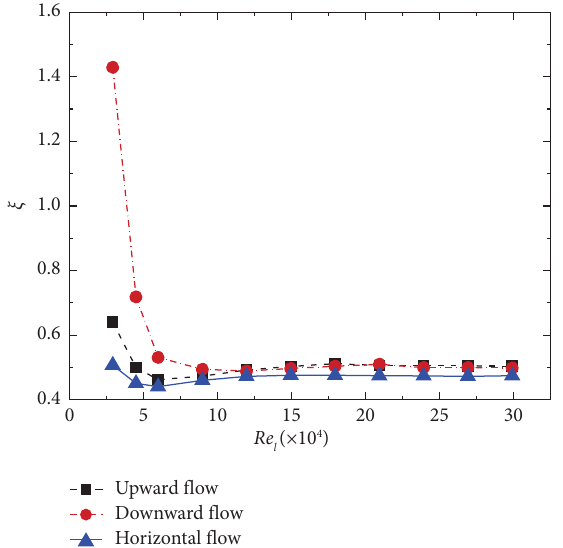
Figure 12: Relationship curves of ξ with Re fow directions in Z-shaped